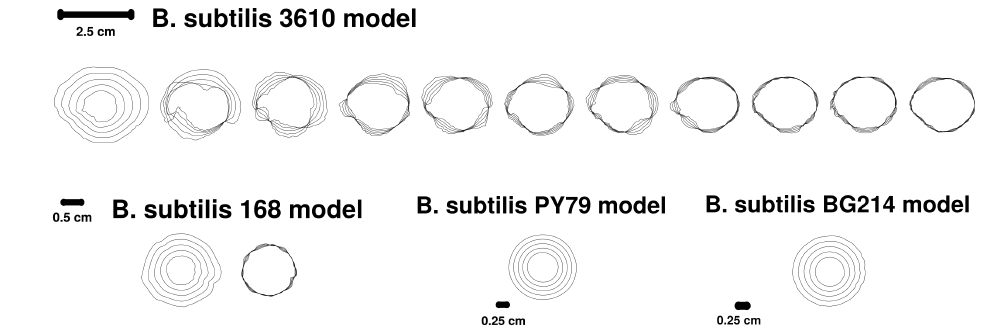
Figure 6. PCA results (after noise elimination of results shown in Figure 5) show distinct colony shape types. Isolated and iterated colony shapes are compared between the monitored phenotypes. Corresponding to Figure 5, colony shapes can be distinguished along their shape variance which tends to be remarkably higher for W3610 and 168 compared to BG214 and PY79, supporting the idea that this could be connected to the aspect of domestication and the ability to swarm. Figure created using Inkscape 0.92.3, available at: https://www.inkscape.org (accessed on 15 September 2022) and celltool